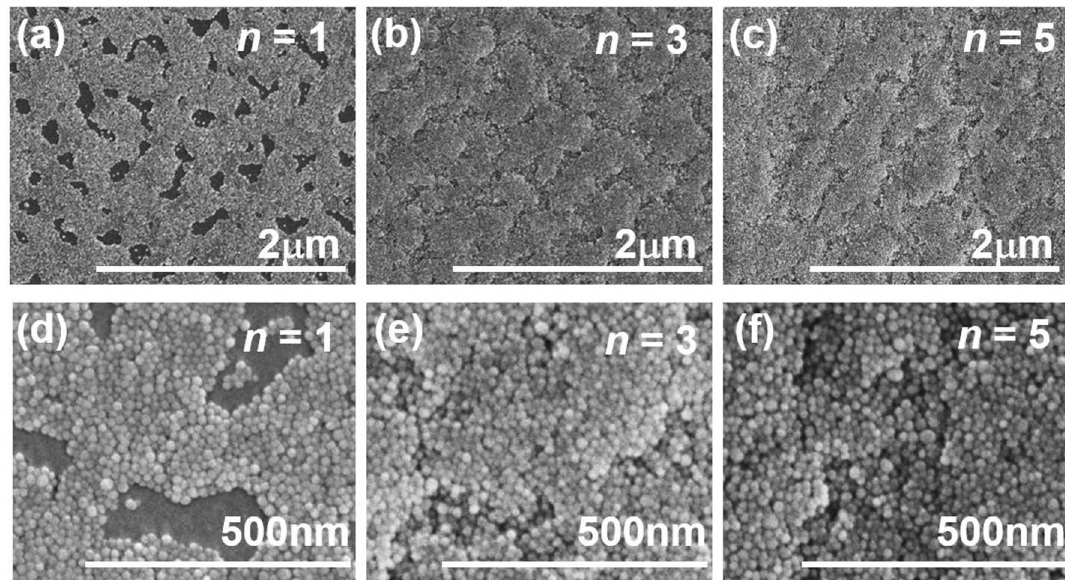
Figure 3. SEM images of the [Pt film/Fe 3 O 4 nanoparticle] n films on the polyimide sheet annealed at T A = 473 K with ( a ) n = 1, ( b ) n = 3, and ( c ) n = 5. ( d ), ( e ), and ( f ) are enlarged SEM images of ( a ), ( b ), and ( c ), respectively.